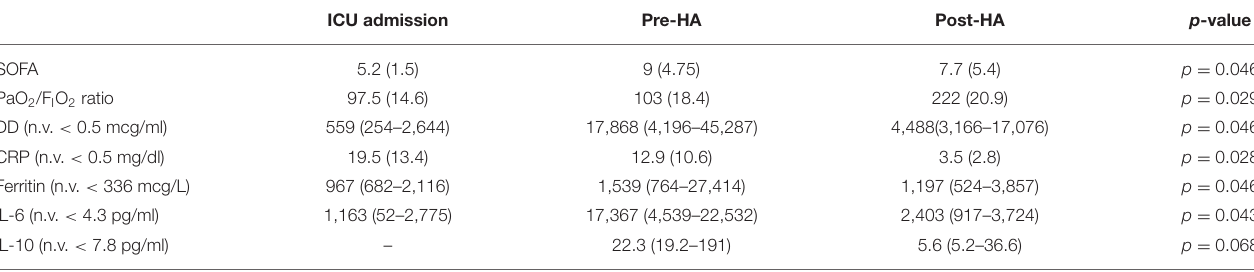
TABLE 2 | Comparison of prehemoadsorption (pre-HA) and posthemoadsorption (post-HA)